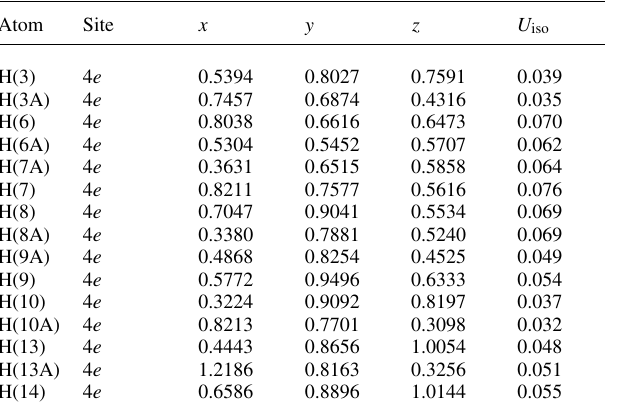
Table 2. Atomic coordinates and displacement parameters (in Å 2 ) .